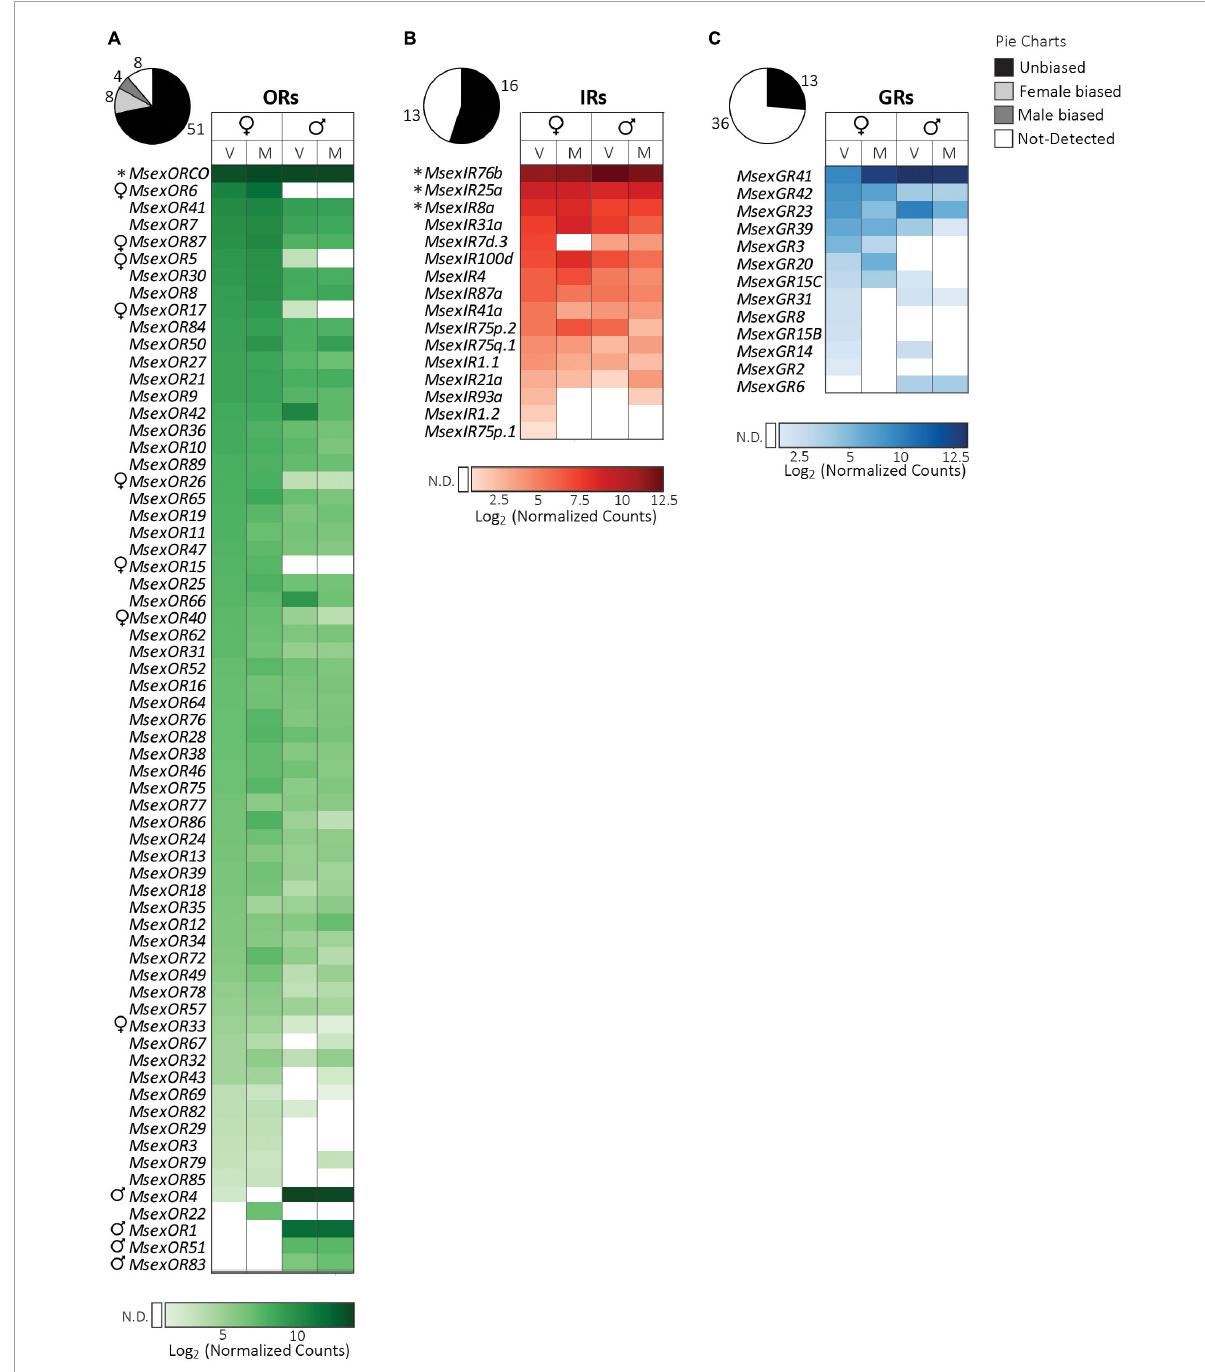
FIGURE1 Expression of chemosensory receptor genes in the antennae of adult M. sexta . (A) Odorant receptors, (B) ionotropic receptors, (C) gustatory receptors. Pie charts depict the percentage of expressed genes (absolute numbers next to the charts) of each receptor family (see legend on top right). Heatmaps were created separately for each receptor family using the log 2 of the geometric mean ( n = 3 biological replicates) of normalized counts obtained from the NanoString assay (see section “Materials and methods”). Light to dark shades indicate low to high counts (see color bar at bottom of each heatmap); white cells indicate no detection (N.D.) of transcripts (for a definition see section “Materials and methods”). Columns represent female and male moths of different mating states (V: virgin, M: mated). Rows represent receptors that were expressed in the antennae of at least one of the four groups, and are sorted first according to values in virgin females, followed by mated females, virgin males and mated males. Symbols next to receptor gene names: ∗ , OR or IR co-receptors; male-biased receptors (FDR corrected p < 0.05, nested ANOVA). Mating states of males and females did not have a significant effect on receptor gene expression (FDR corrected p > 0.05, nested